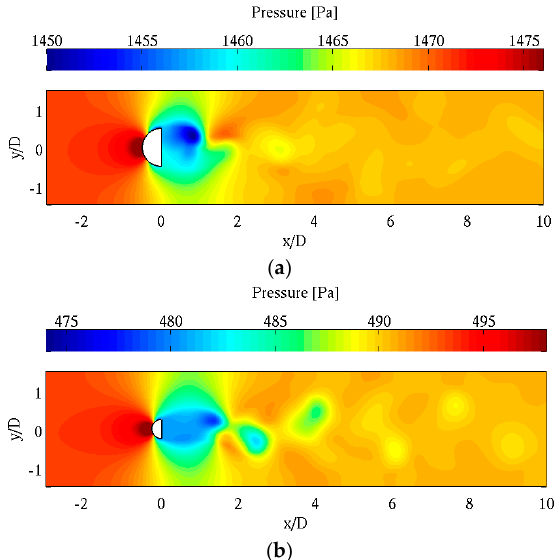
Figure 7. Vertical vorticity component ( t = 86.5 s) at ( a ) z / D = − 0.5; ( b ) z / D = 0.5; and ( c ) z / D = 0.0 along with the experimental visualization for z/D = − 0.5 and z / D = 0.5.